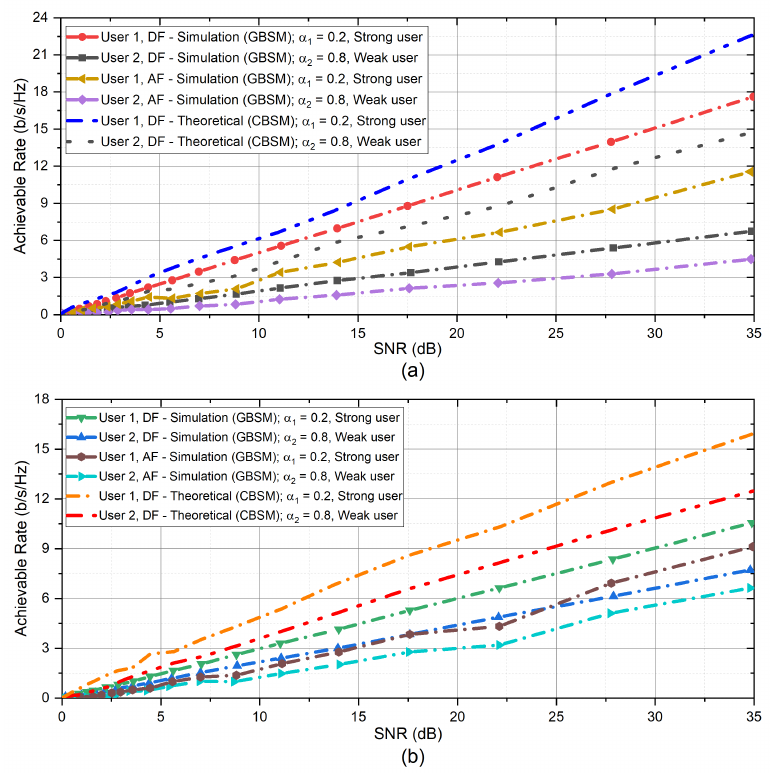
Figure 6. Achievable rates of DF and AF schemes of the proposed 3D channel model with ( a ) URA and ( b ) CA.